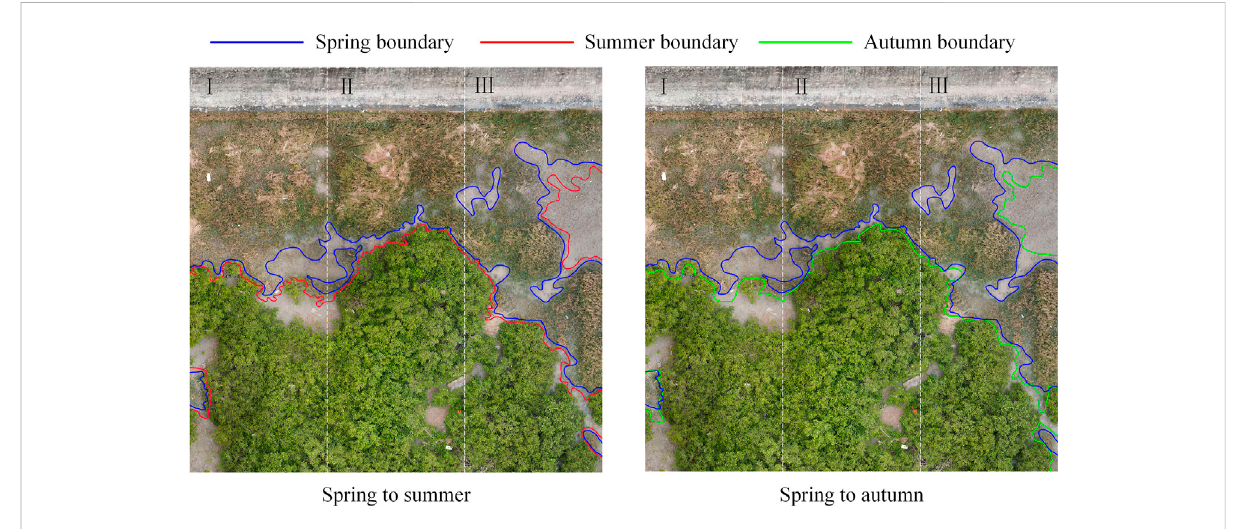
FIGURE 5 The actual distribution pro fi le of S. alterni fl ora